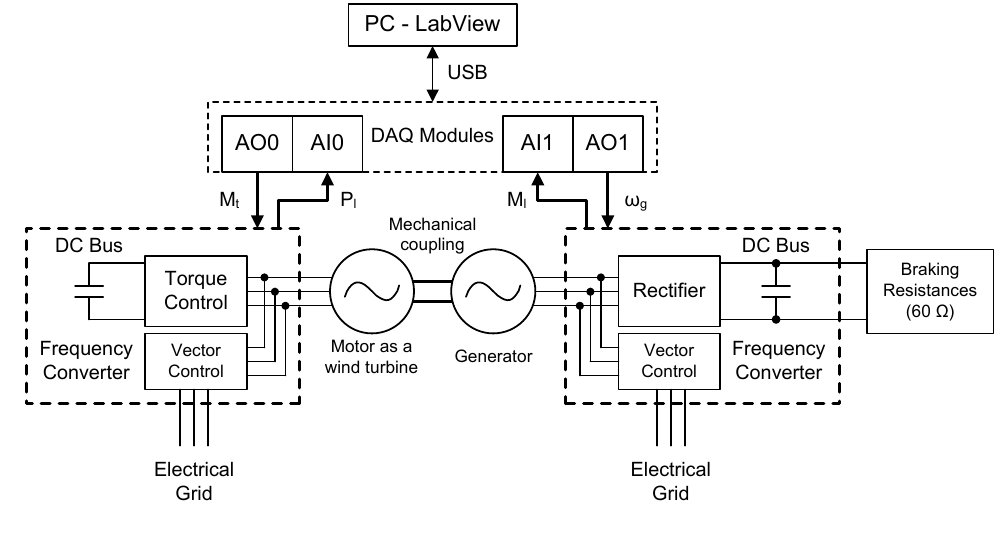
Figure 1. Schematic diagram representing the motor-turbine and generator